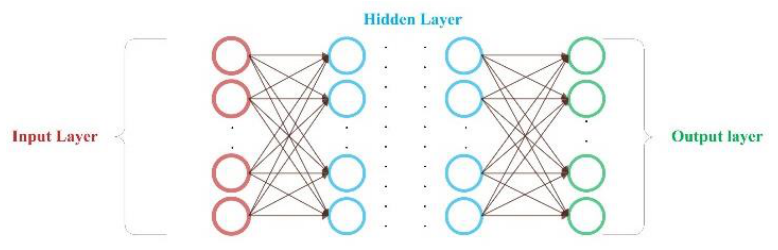
Figure 10. A sample ANN structure.